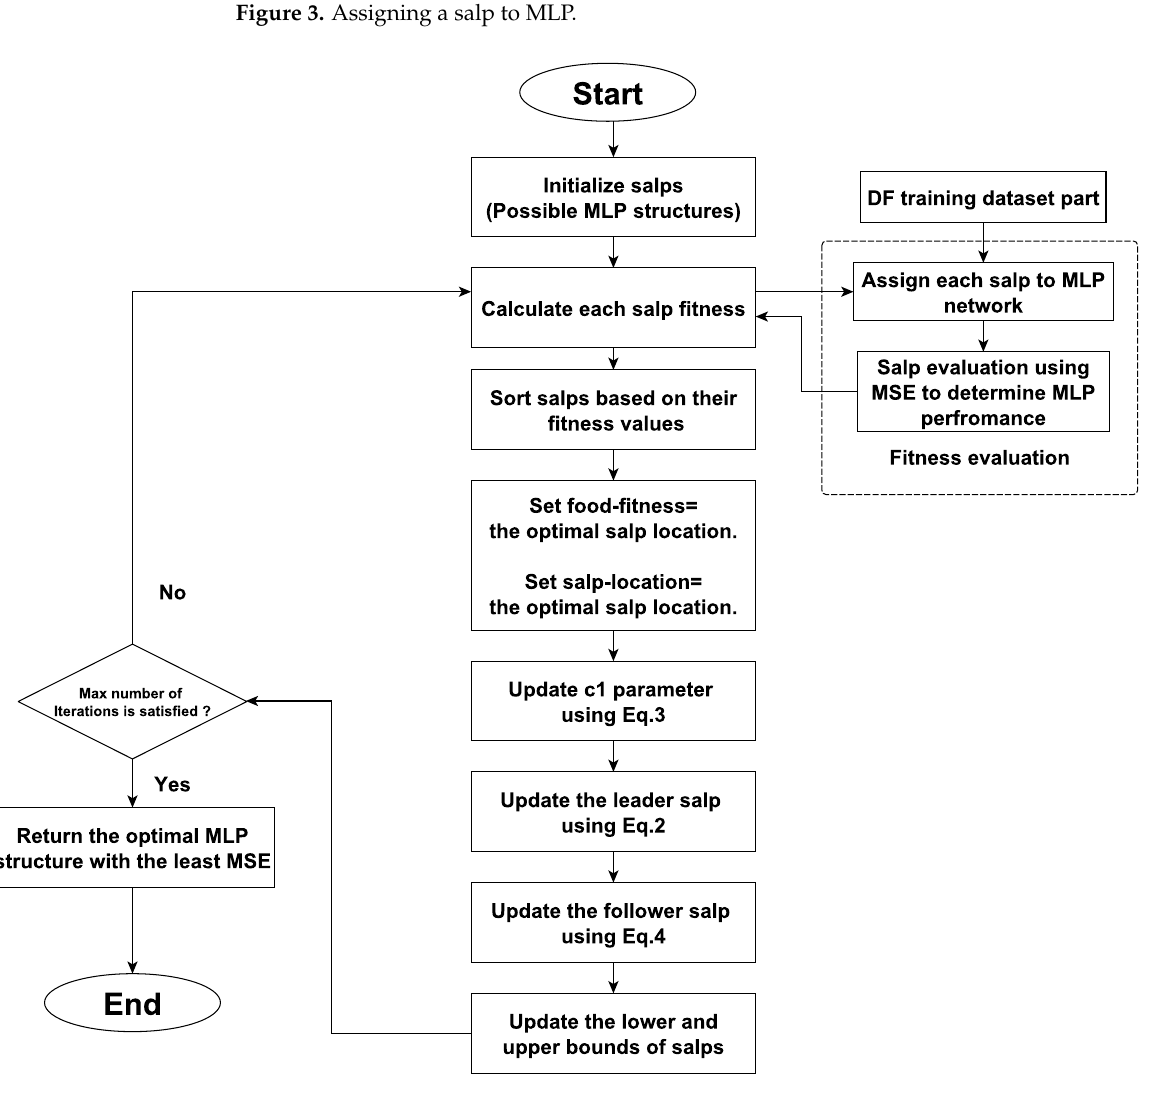
Figure 4. DF-SSA-MLP